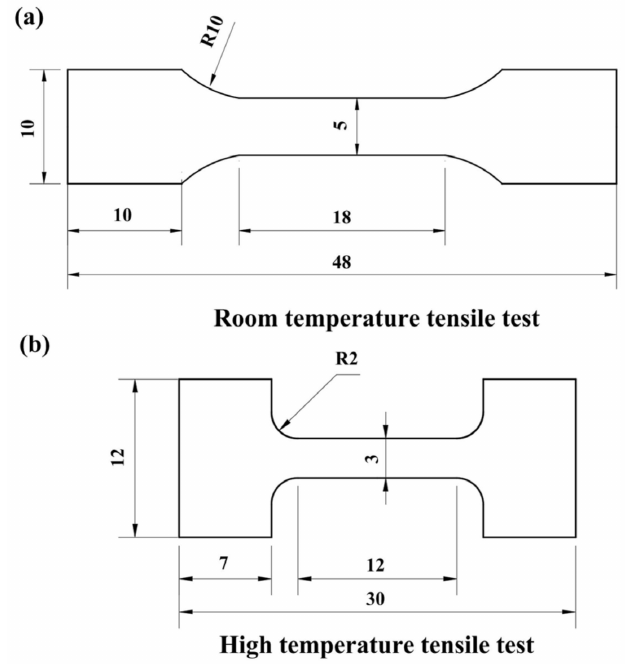
Figure 2. Dimensions of the specimens used for tensile testing. ( a ) Room-temperature tensile test; ( b ) high-temperature tensile test (all dimensions are in mm).